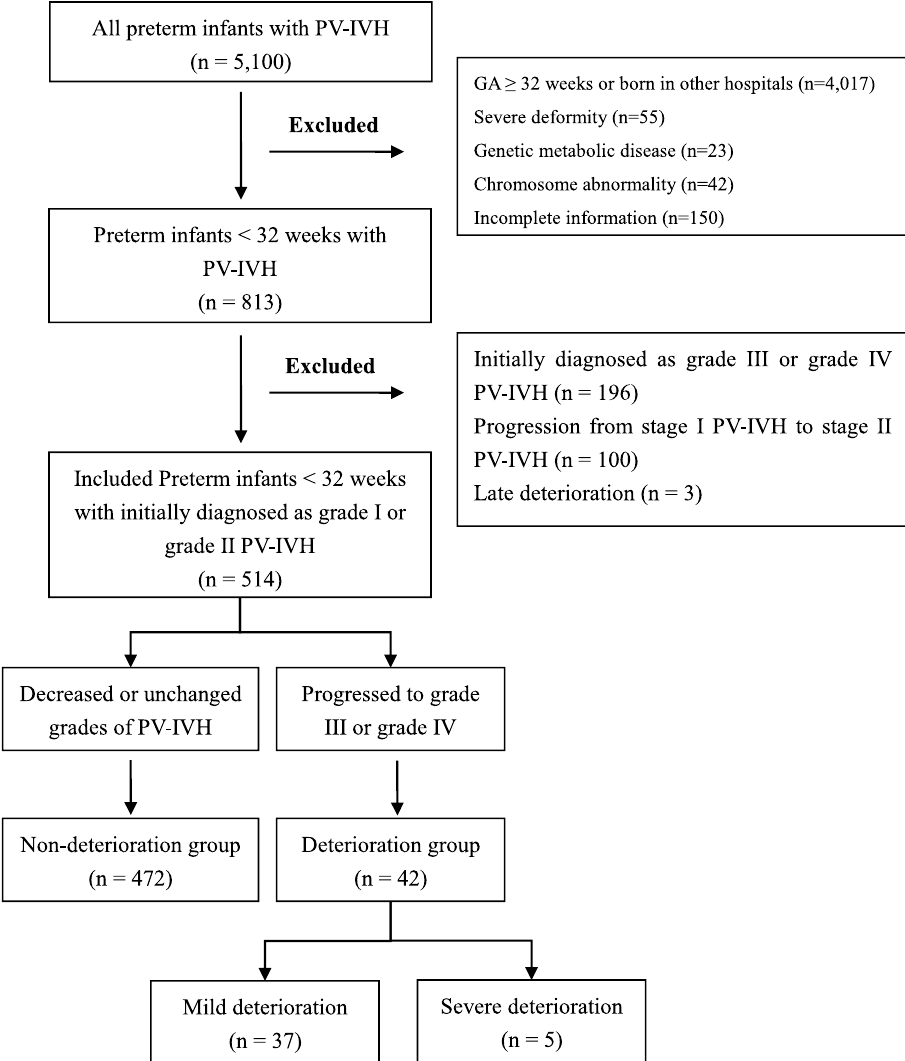
Figure 1. Flow chart in selection of preterm infants with PV–IVH. *Initial diagnosis of PV–IVH was within 72 h after birth. Reexamination of ultrasound was periodic after initial